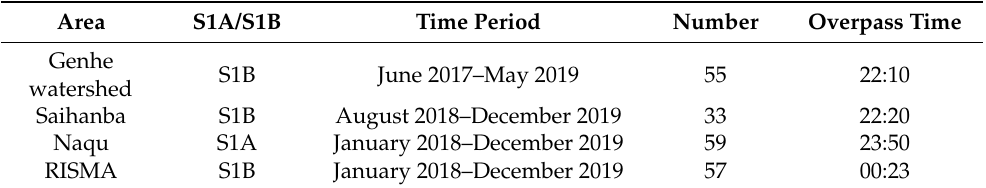
Table 2. Detailed information on S1 data over the four study areas. Number means the number of S1 SAR images during the time